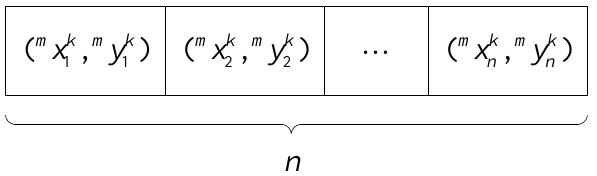
Figure 5. The encoding format of path T k m .